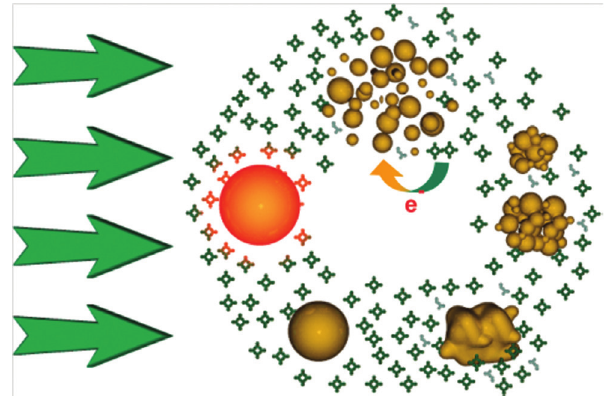
Figure 21 Image of the supposed self-healing mechanism of AuNP (brown dots) during laser irradiation (green arrows) in the presence of zinc phthalocyanines (green stars) (reprinted with permission from [109]). Copyright 2009, American Chemical